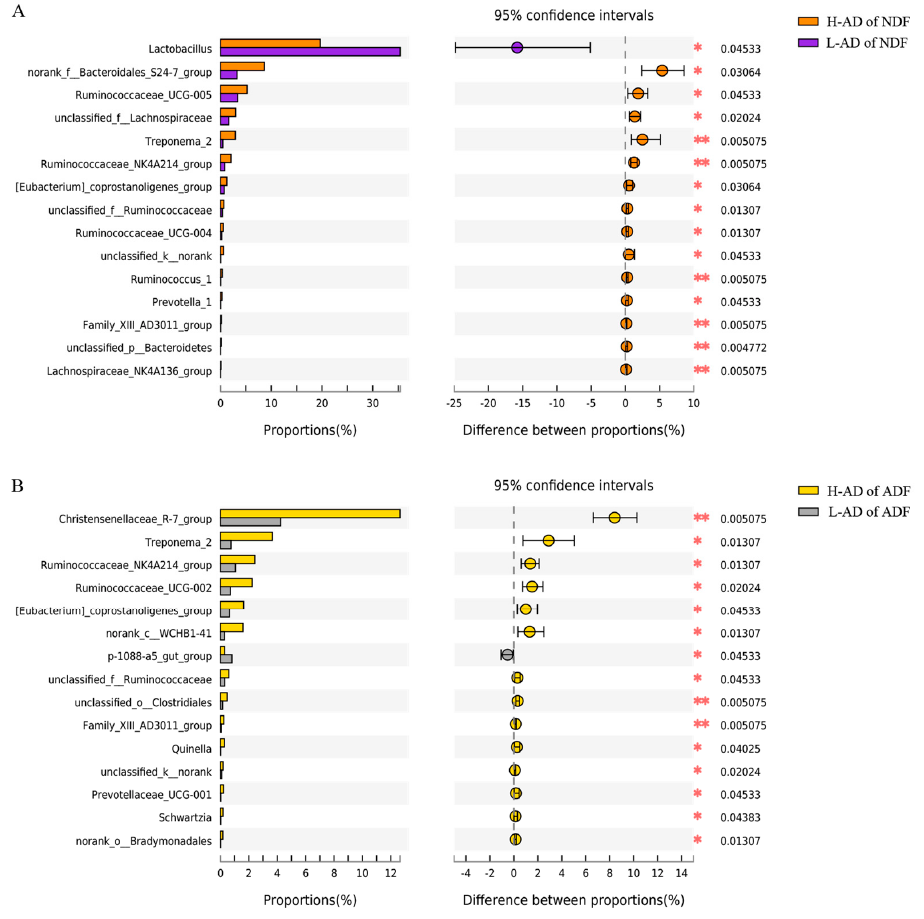
Figure 3. The bacterial abundances of distinct genera significantly different between the H- and the L-AD of NDF ( A ) and ADF ( B ). Extended error bar plot showing the fifteen most abundant genera that had significant differences between H- and L-AD of NDF and ADF. Positive differences in mean relative abundance indicate genera overrepresented on H-AD of NDF and ADF, while negative dif- ferences indicate greater abundance in L-AD of NDF and ADF. ** The mean difference is significant at a level of 0.01, * The mean difference is significant at a level of 0.05.